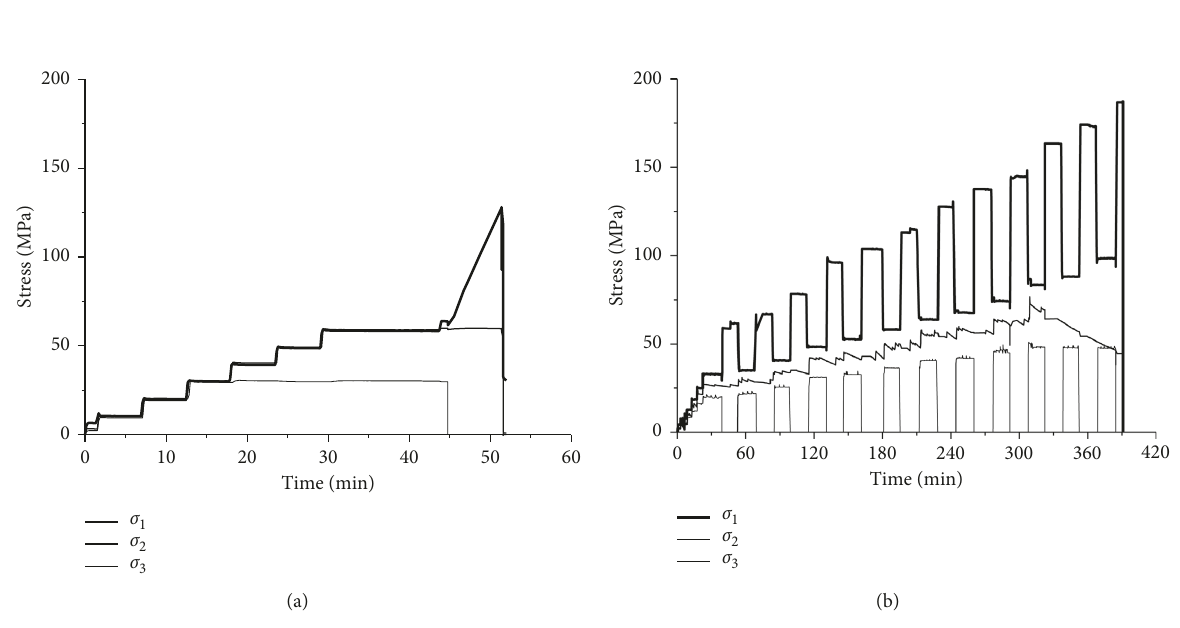
Figure 1: Stress-time curves of (a) granite and (b) argillaceous sandstone [22] in the laboratory strain burst experiments.